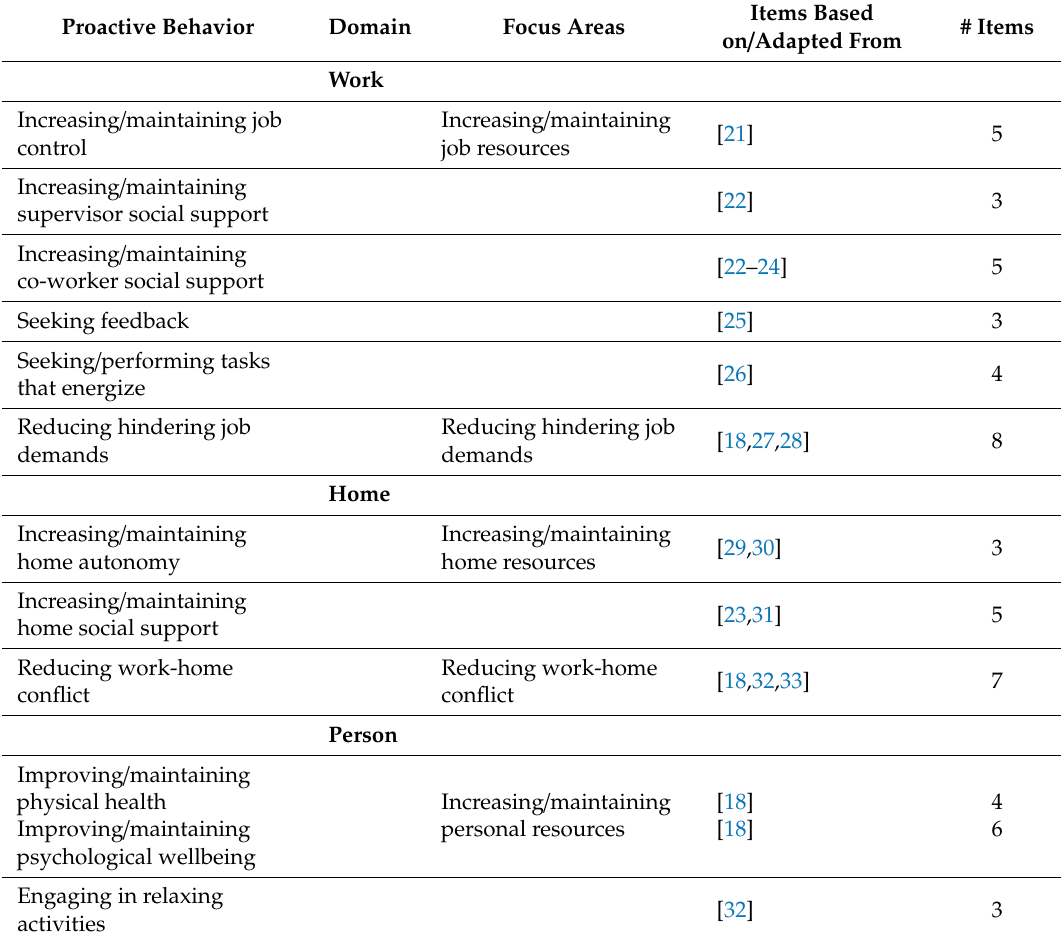
Table 1. Proactive Burnout Prevention Behaviors: Domains, Focus Areas, Source and Number of Items. Proactive Behavior Domain Focus Areas